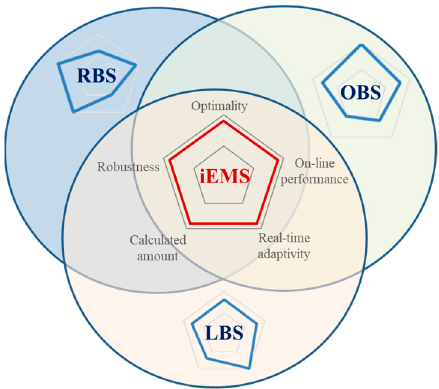
Figure 1. The iEMS based on hybridization/nested concept.